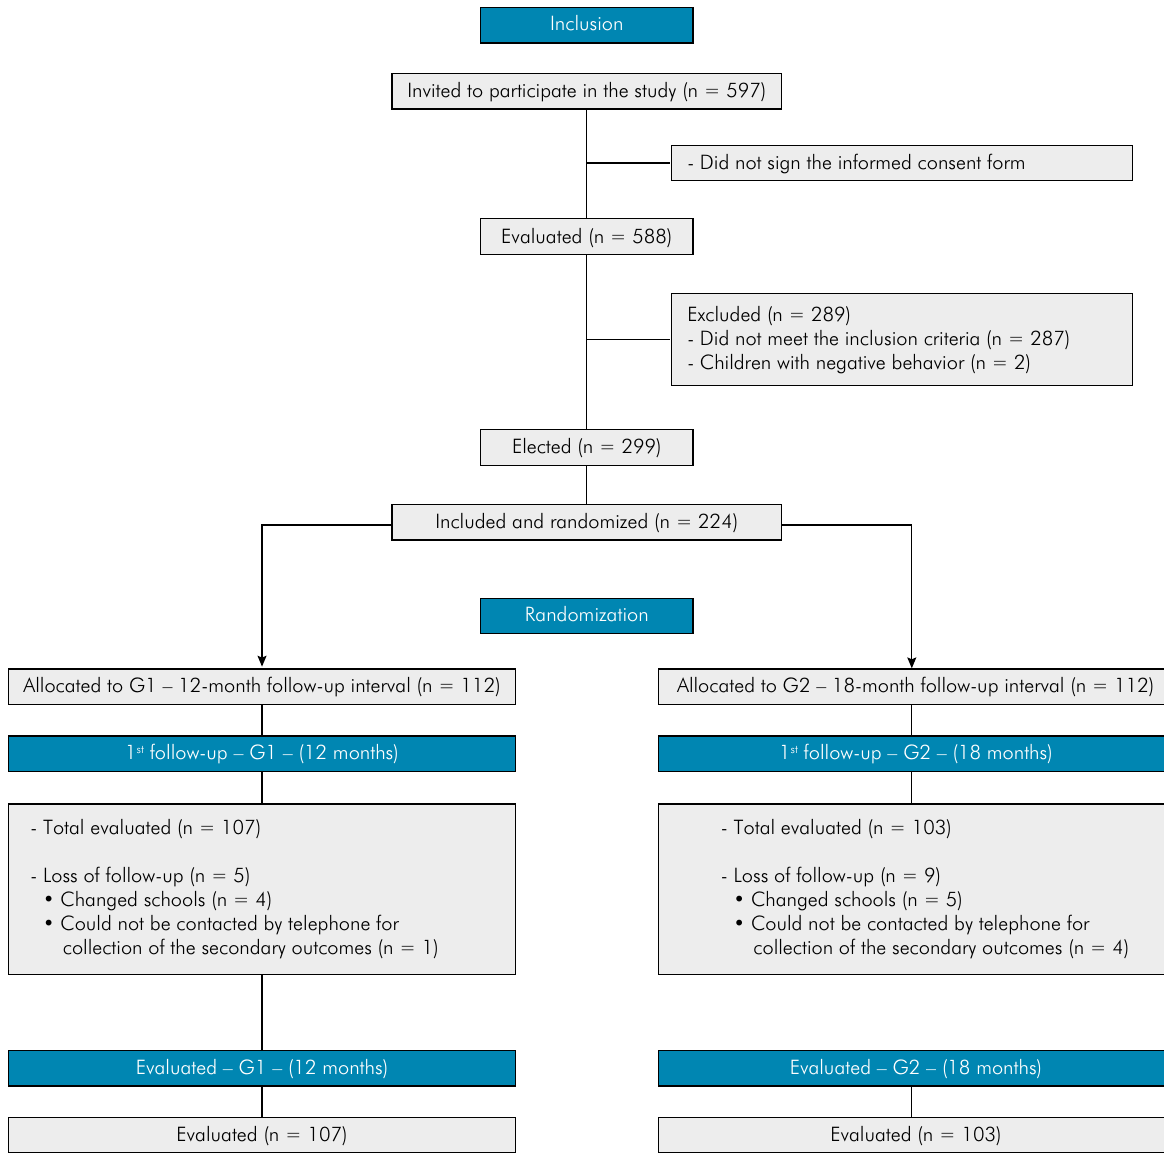
Figure. Flowchart of inclusion of the children in the